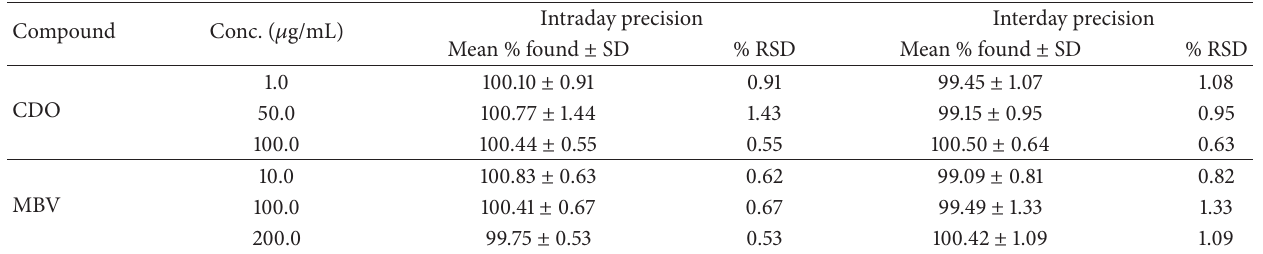
Table 3: Precision data for the determination of CDO and MBV by the proposed